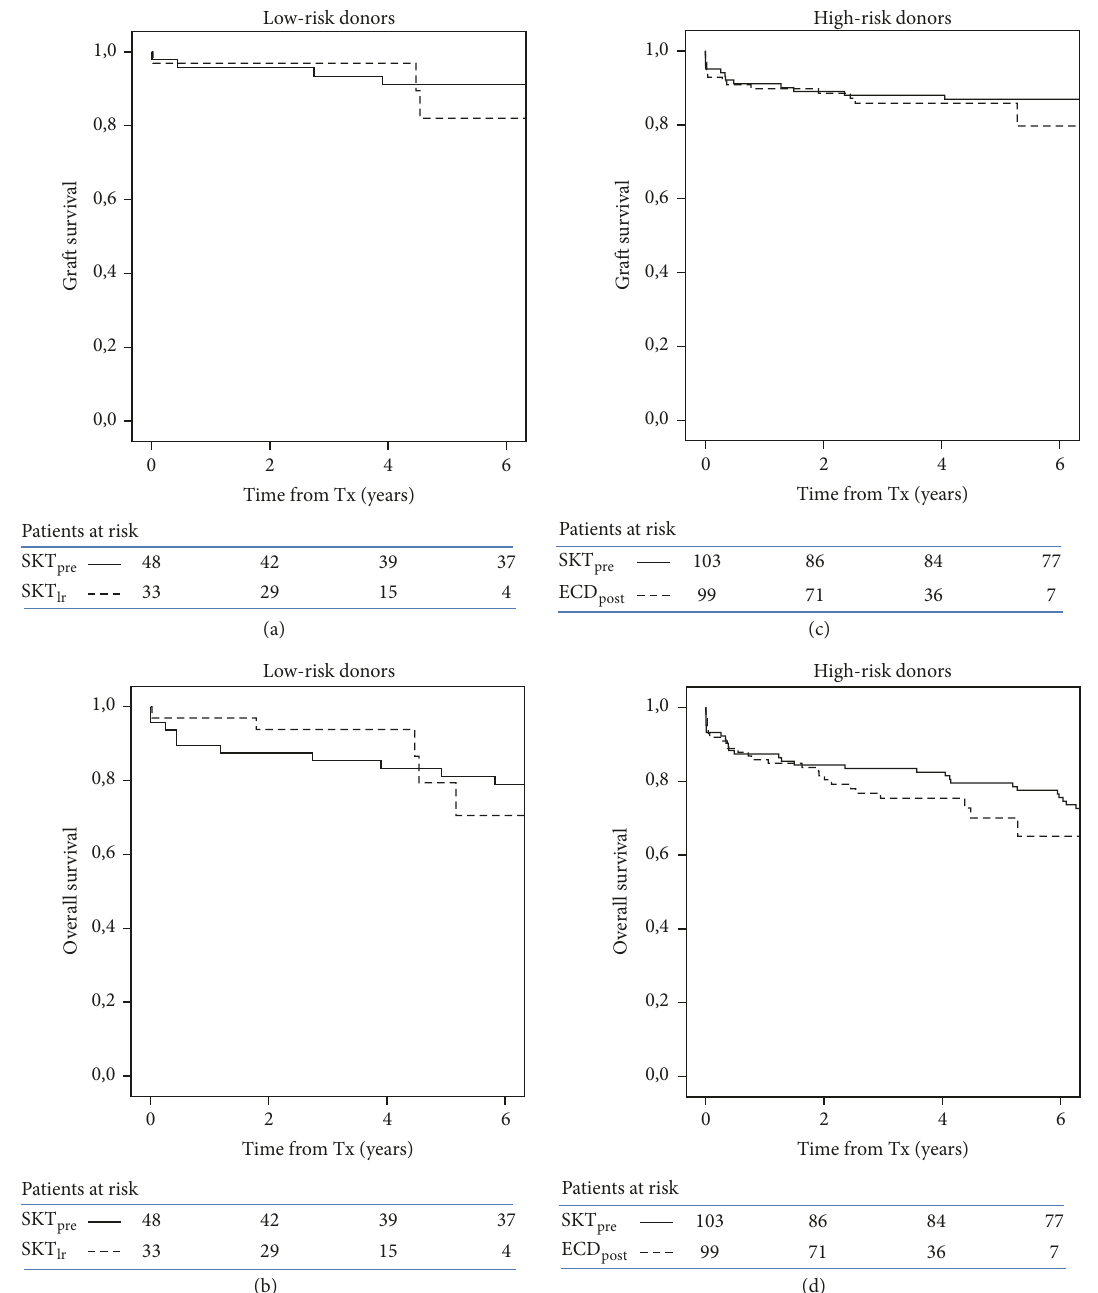
Figure 2: Kaplan-Meier plots of graft (a, c) and overall survival (b, d) in transplants by donor category (low-risk and high-risk) and period (SKT : pre-DKT donors; SKT pre not significant.